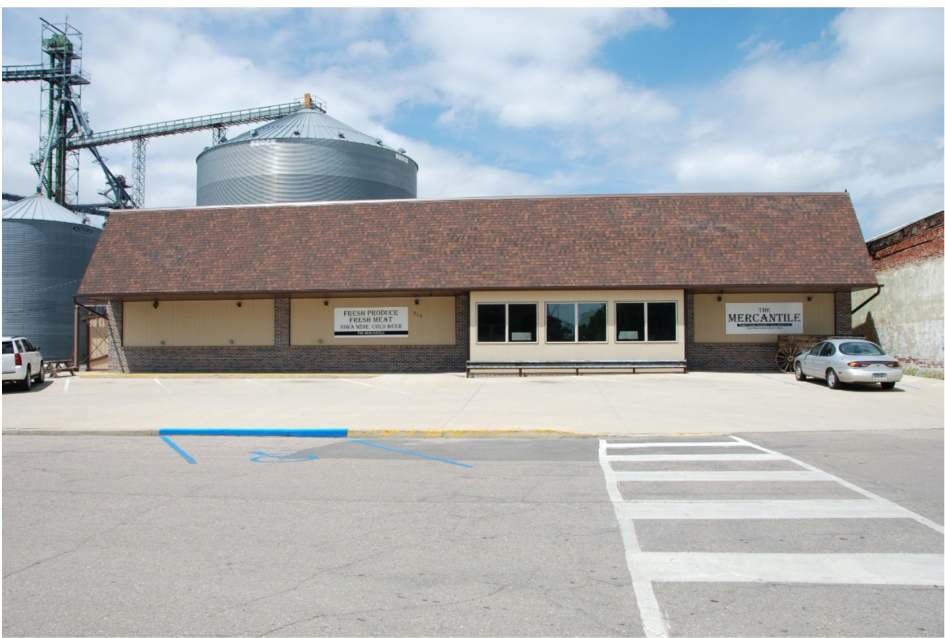
Figure 6. From transect across Northwest Iowa: Stage 2–End of Life. The Mercantile in Correctionville,